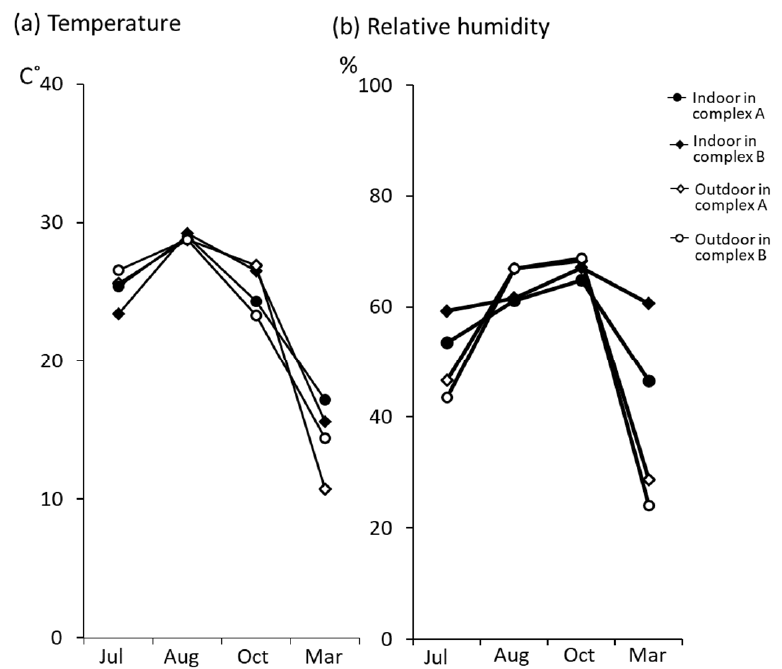
Figure 6. Time drift of temperature and relative humidity in two temporary housing-complexes. We measured temperature and relative humidity 4 times a year for covering four seasons (rainy season in July, summer in August, autumn in October, and winter in March). ( a ) Temperature and ( b ) relative humidity. The 16 rooms in the temporary housing-complex A and the 22 rooms in the complex B were sampled, and the average were calculated in rooms in each complex.